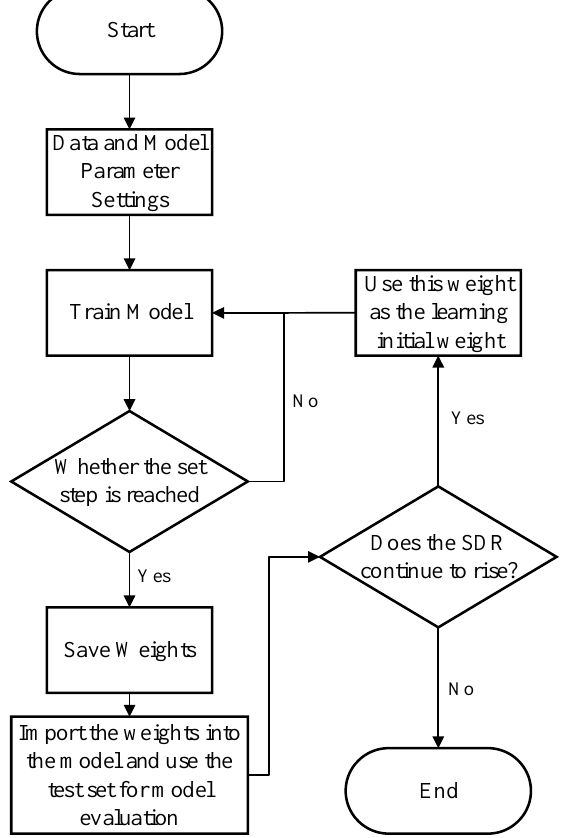
Figure 4. Voice filter model train flow chart.